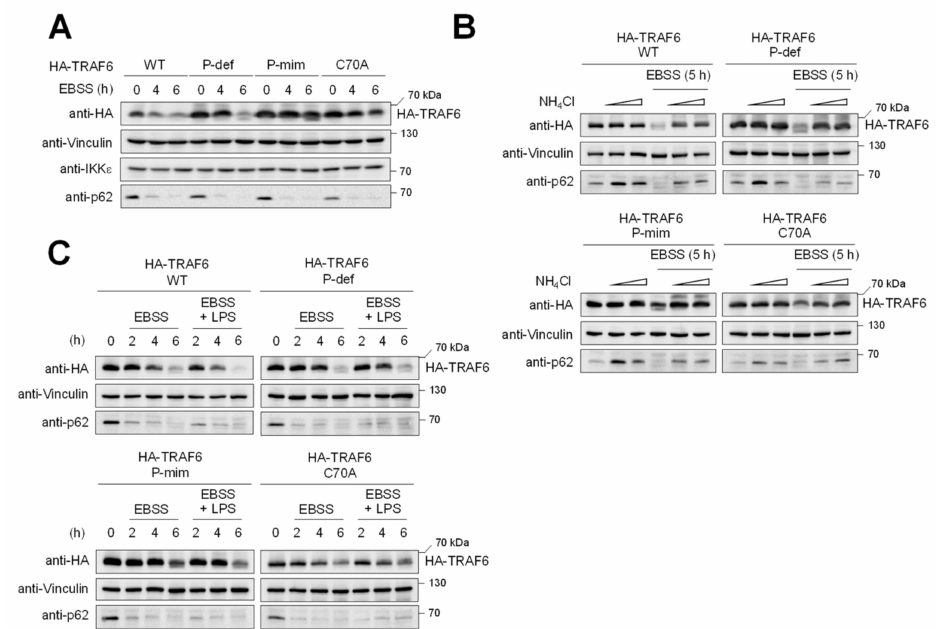
Figure 5. Analysis of TRAF6 degradation during autophagy. ( A ) The indicated cell lines were incubated in autophagy- inducing EBSS medium for the indicated periods. Cell extracts were analyzed by immunoblotting to visualize the decay of TRAF6 and of p62, a well-known substrate of the autophagosome. ( B ) Cells were incubated in the absence or presence of EBSS medium and/or NH 4 Cl (10–50 mM), as shown. The effects on the amount of TRAF6 and the other indicated proteins were measured by immunoblotting. ( C ) The experiment was conducted as in ( B ) with the exception that cells were incubated with EBSS and/or